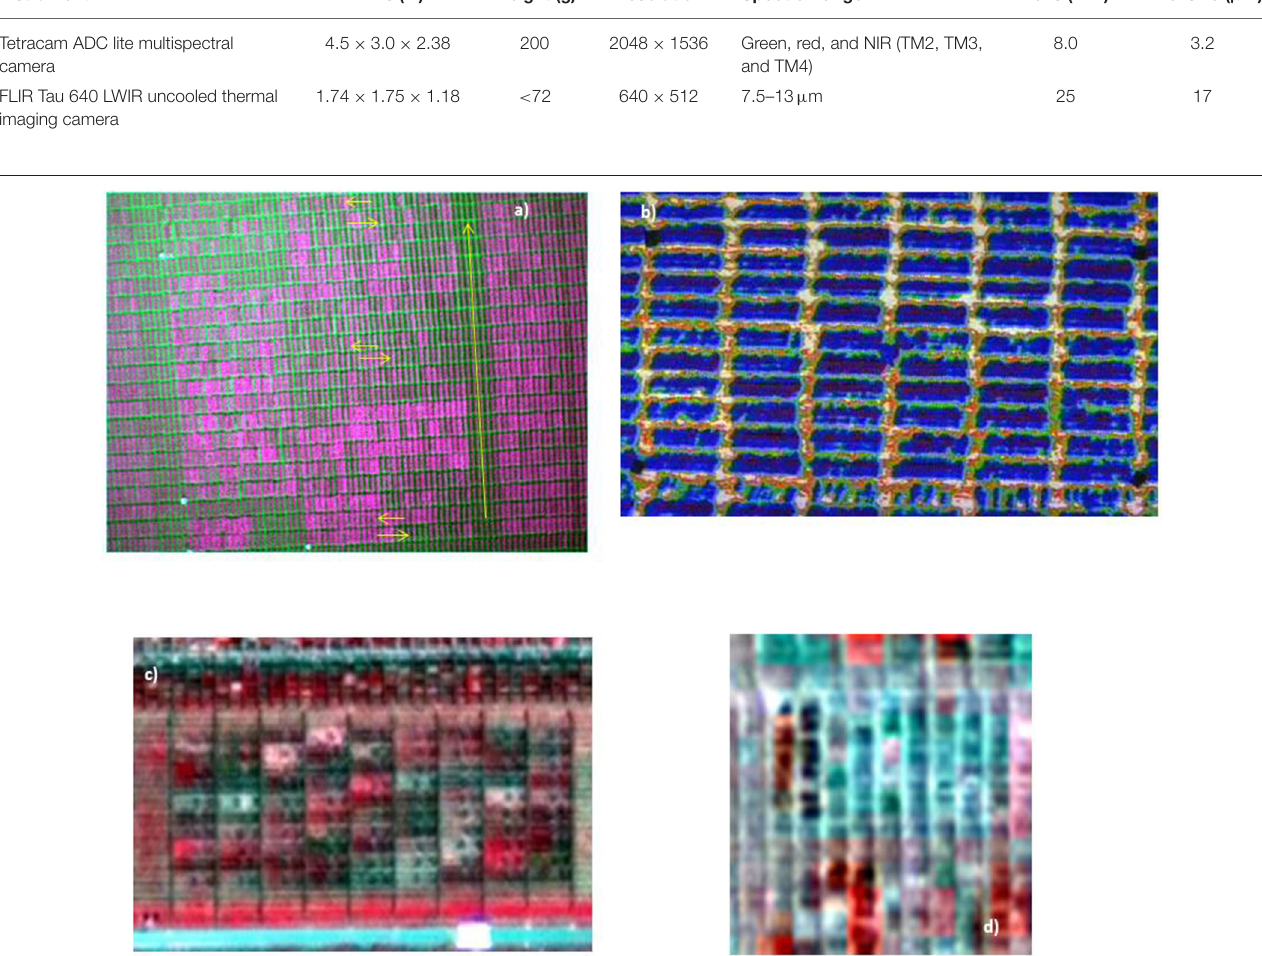
FIGURE 2 | (A). Raw image of Gen Res DRT trial within the drought environment, taken using the ADC Lite Tetracam on the UAV, approximately at 100m height. Ground dimensions of plots are 2 × 0.8 m, with arrows representing direction of proximal measurements. Assuming a measurement time of 10s per plot, the time taken to complete measurements using proximal sensors is ∼ 69min for this trial, compared to several seconds with the UAV. (B) Raw image of a “HOT” trial extracted from video footage from the FLIR Tau thermal camera. Flight altitude was ∼ 30 m. Ground dimensions of plots are 2 × 0.8 m. (C) Pan-sharpened WV-2 imagery of Elite OPT. Pan-sharpened imagery of a trial containing smaller sized plots in (D) did not allow for the extraction of NDVI as plots were mixed within